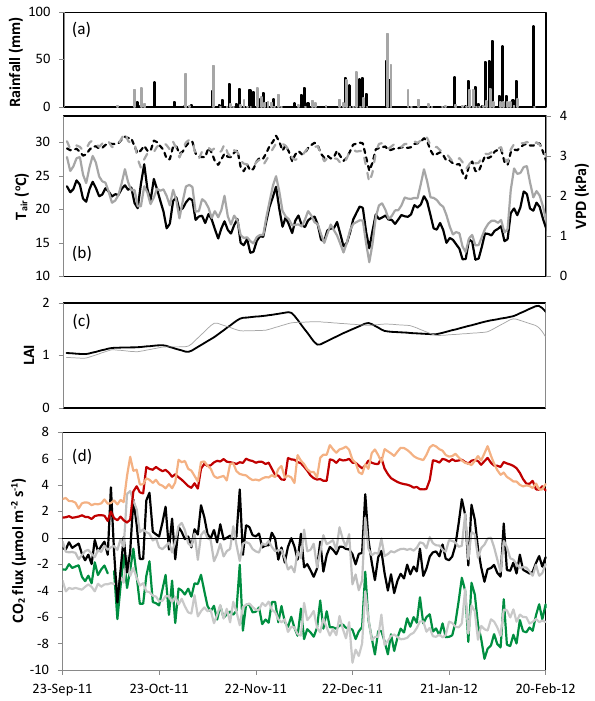
Figure 2. Comparative meteorology and fluxes for the uncleared (UC) and cleared savanna CS sites prior to the clearing event. Data spans the late dry season (September 2011) through to the middle of the wet season prior to the clearing event of 2–6 March 2012. Plots include (a) daily precipitation (black bars UC site, grey bars CS site), mean daily T air (black lines UC, grey CS), (b) mean daily VPD (dashed lines; black UC, grey CS), (c) interpolated 8-day MODIS LAI (black UC, grey CS), (d) NEE (black UC, grey CS) partitioned into R e (red UC, pink CS) and GPP (dark green UC, pale green CS).